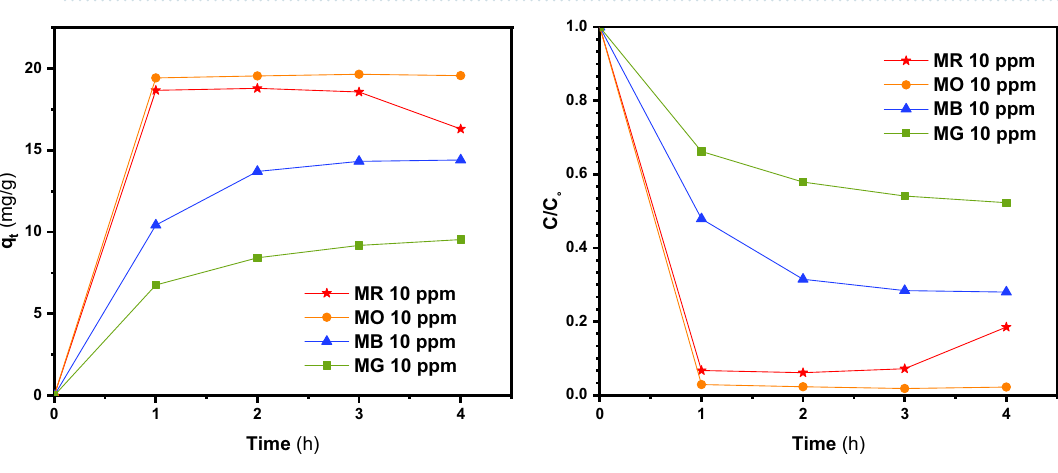
Figure 10. Stability tests of different dyes at concentration of 10 ppm for